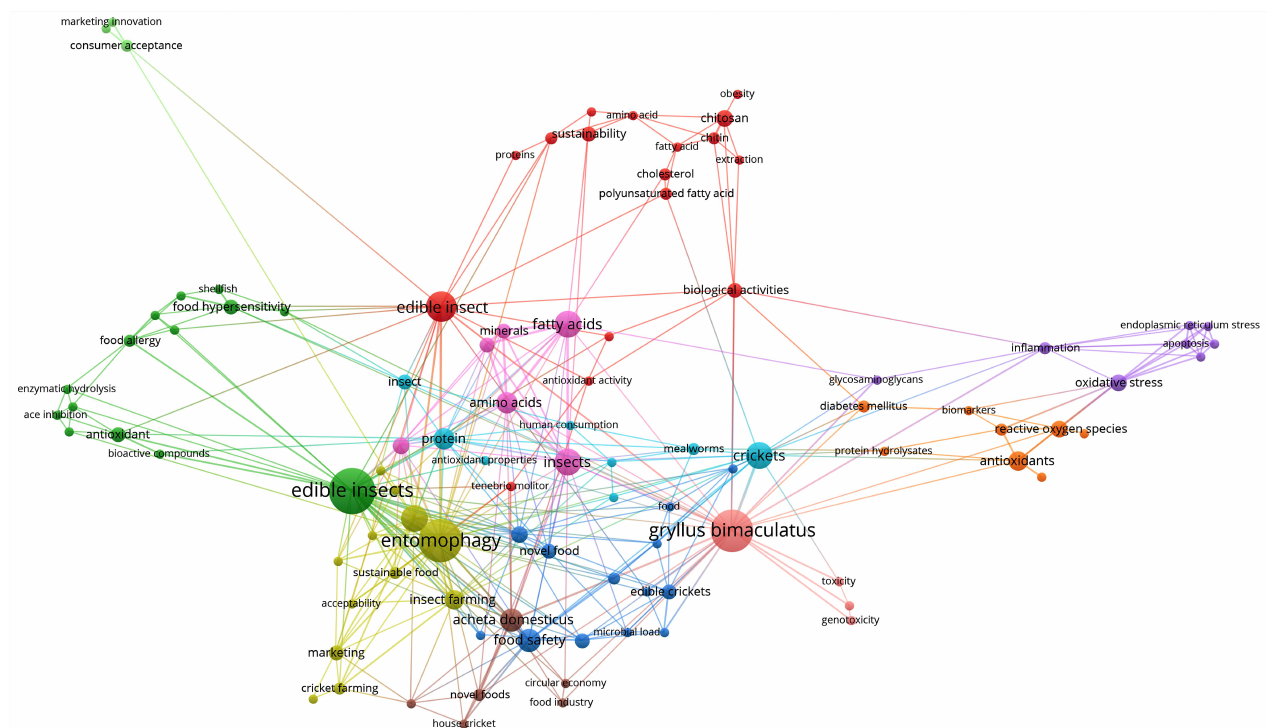
Figure 1. Analysis of co-occurrence links between keywords of used bibliographic sources in this review (counted when each keyword appeared at least